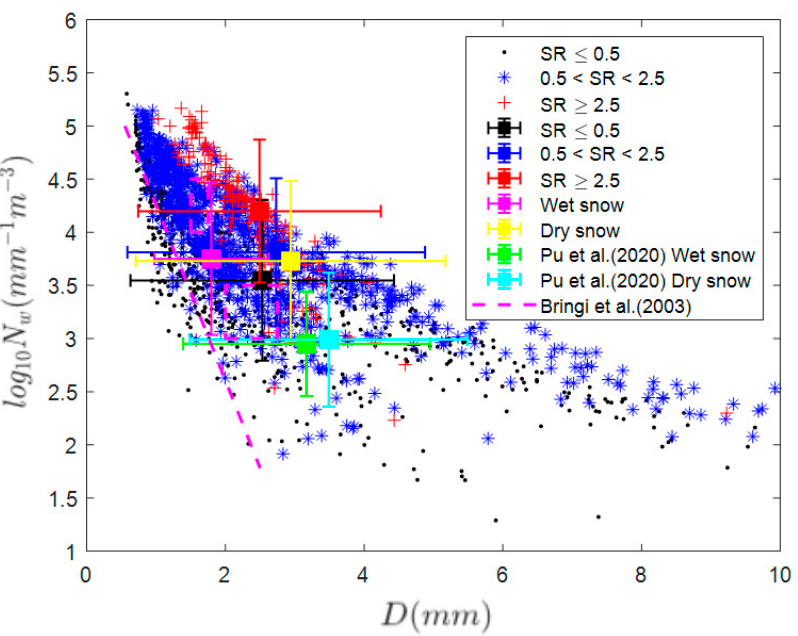
Figure 5. The scatter distribution and mean values (the length of the error bar is the standard deviation) of log 10 N w and D m of different S R [36,54]. The green and cyan blocks in Figure 5 are the mean values of wet snow and dry snow Table 2. The mean (ME) and standard deviation (SD) of log 10 N w and D m of different types of snow. analyzed by Pu et al. [54] in Nanjing. According to Pu et al. [54], local 1-h ground temper- ature data for precipitation days are used to distinguish between dry snow and wet snow. Snow Types